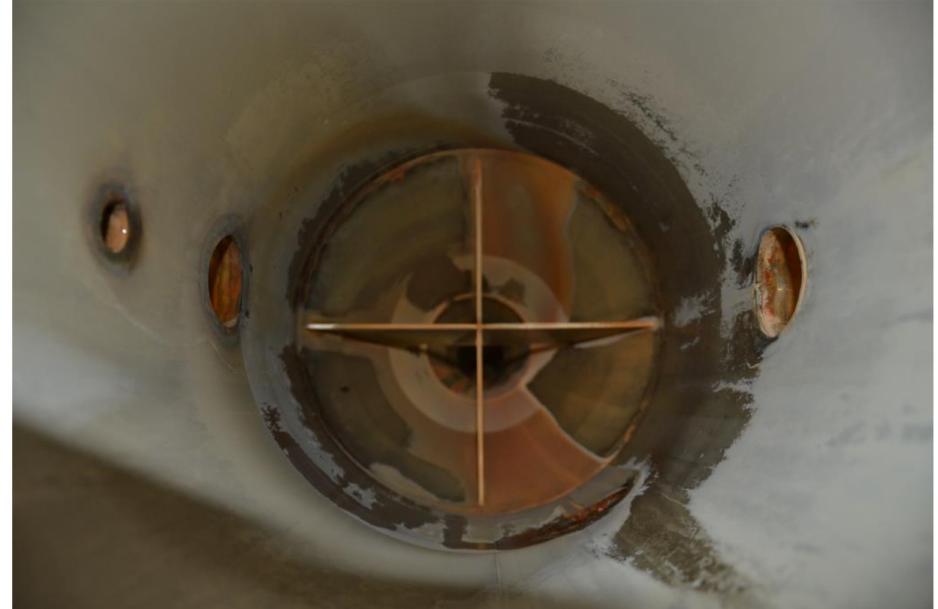
Figure 11. Interior of the vacuum cooler with minimal deposits. Mainly a faint white coating of calcium carbonate is